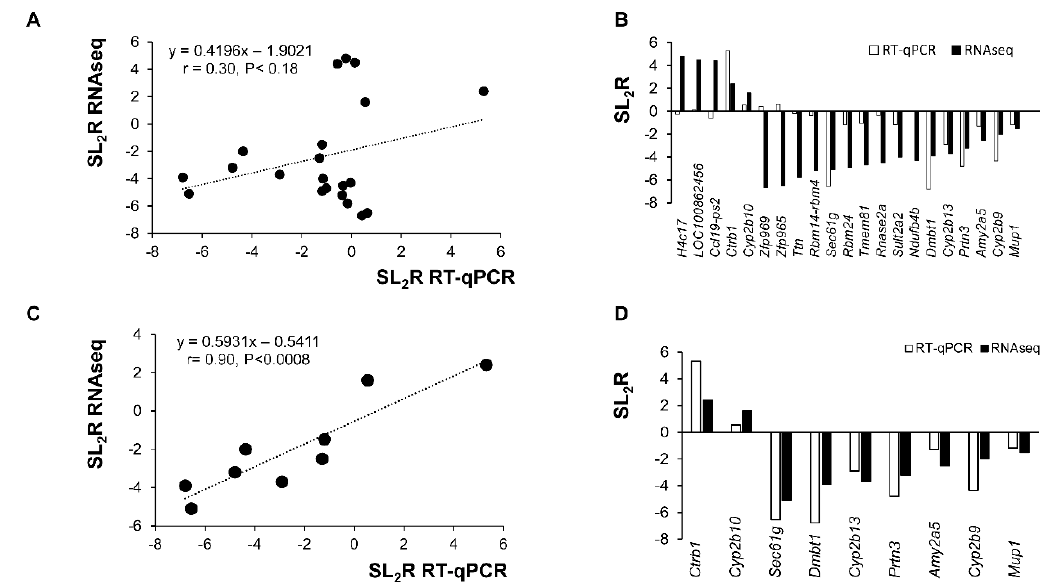
Figure 5. Concordance between used methods of RNA analysis. ( A ) Correlation analysis of 21 selected genes between RNAseq and RT-qPCR normalized to the invariant Pipb and Tbp genes. The mean values obtained for signal log 2 ratio (SL 2 R) from individual analyses (Table 3) were plotted against the RNAseq which used partially pooled samples (Tables 1 and 2). Poor agreement between the procedures was seen ( r = 0.3, p < 0.18). ( B ) Changes in values of SL 2 R expression of both methods for the 21 selected genes. ( C ) SL 2 R correlation analysis between between RNAseq and RT-qPCR results normalized to the invariant Pipb and Tbp of 9 filtered genes after excluding those without counts in more than 60% of samples. Good agreement between the procedures was observed ( r = 0.8, p < 0.0008). ( D ) Changes in values of SL 2 R expression of both methods for the 9 after removing those with low counts.